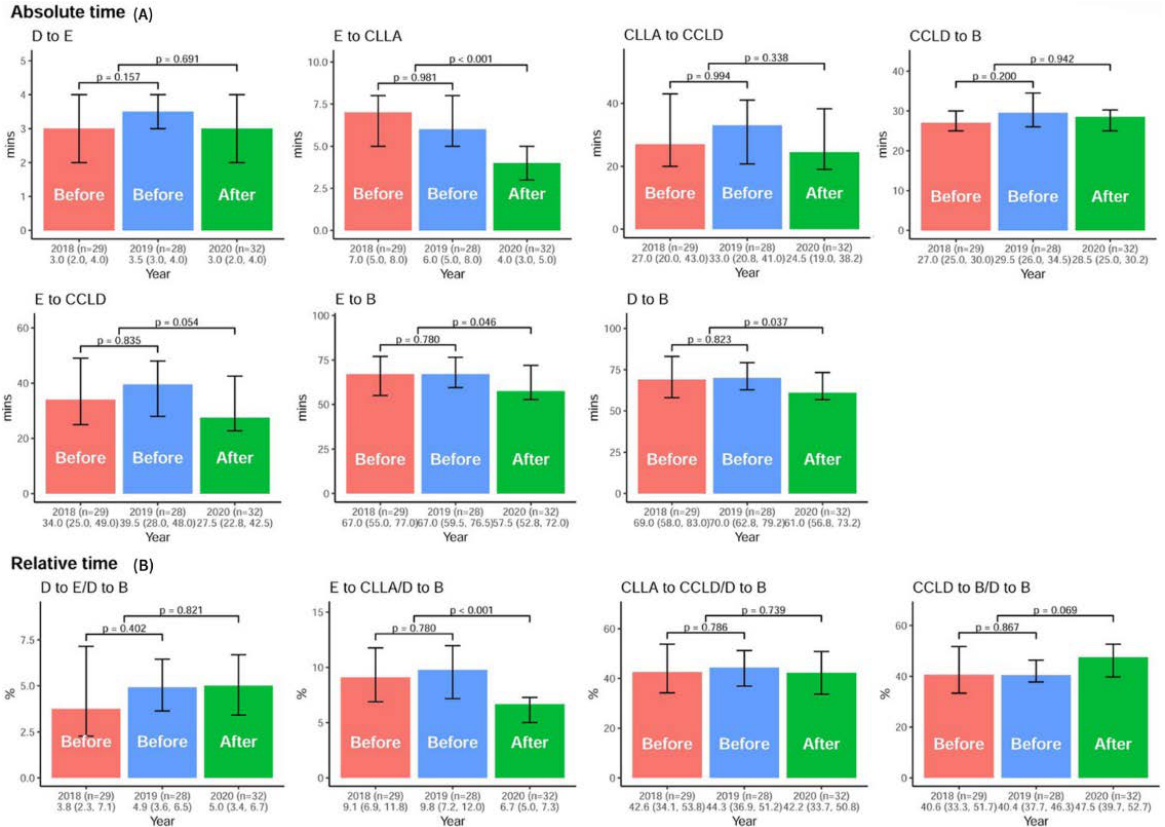
Figure 4. The DtoB time metrics before and after the AI-based alarm strategy. ( A ) The comparison of the median DtoE, EtoCCLA, CCLAtoCCLD, CCLDtoB, EtoCCLD, EtoB, and DtoB times before and after AI-S implantation. ( B ) The relative time ratio between each time component over DtoB